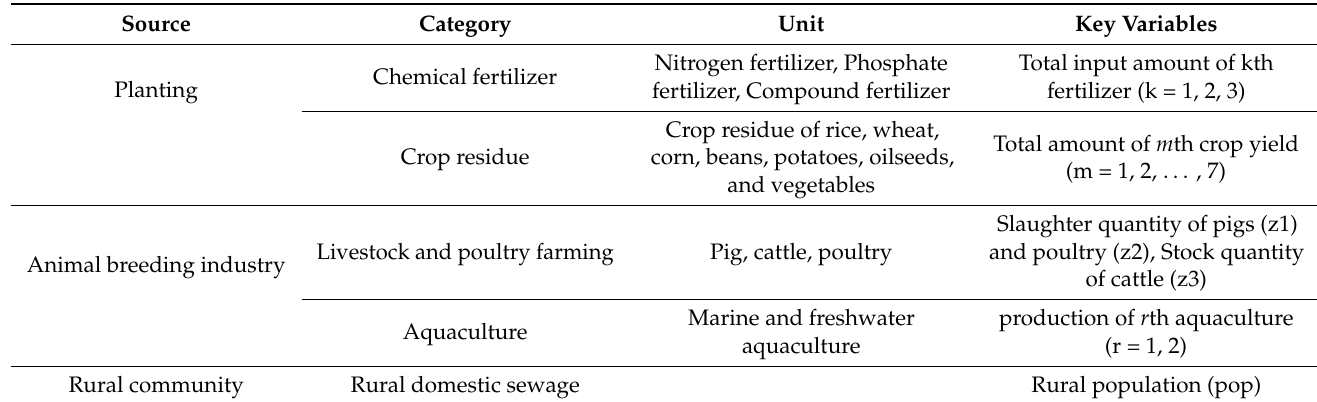
Table 1. Agricultural Non-point Source Pollution Measurements.